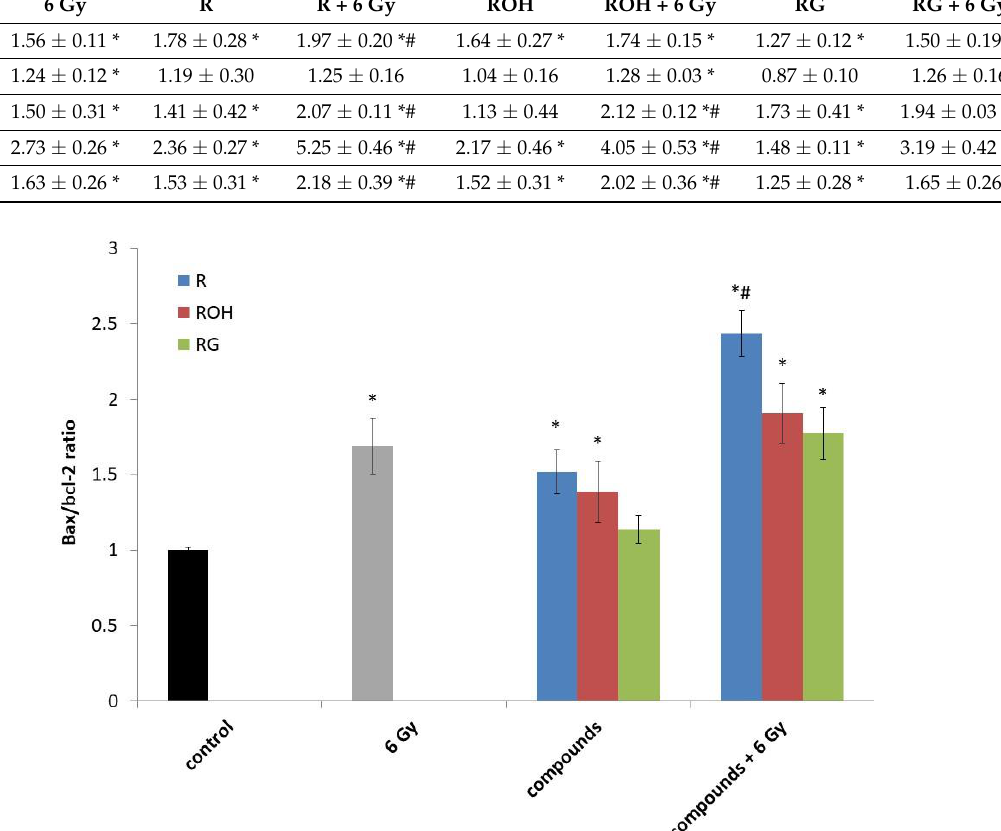
Table 1. Effect of resveratrol (R), piceatannol (ROH), and piceid (RG) at concentrations of 25 µ M, IR (dose of 6 Gy), and their combinations on the transcription of genes involved in the apoptosis of MCF-7 cells. Gene expression was normalised to the HPRT housekeeping gene. The delta–delta Ct method was used to determine the relative levels of mRNA expression between the experimental samples and controls. The mean difference (*) was compared with the control and (#) with IR. Control 6 Gy Control 6 Gy R R + 6 Gy ROH ROH + 6 Gy